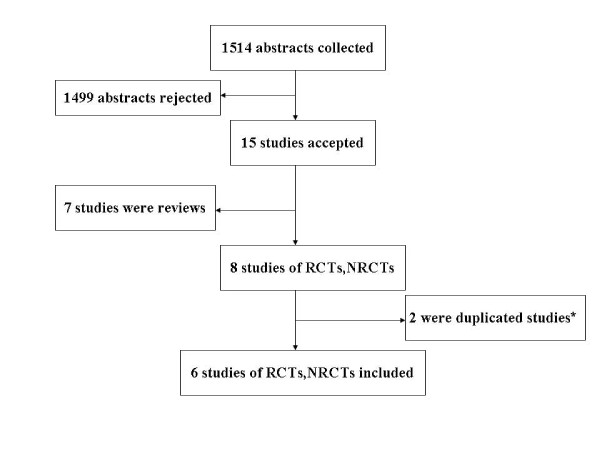
Results of literature search.* Three studies were published from the same group of investigators [23,29,30]. Only the most updated publication with a completed dataset was included.